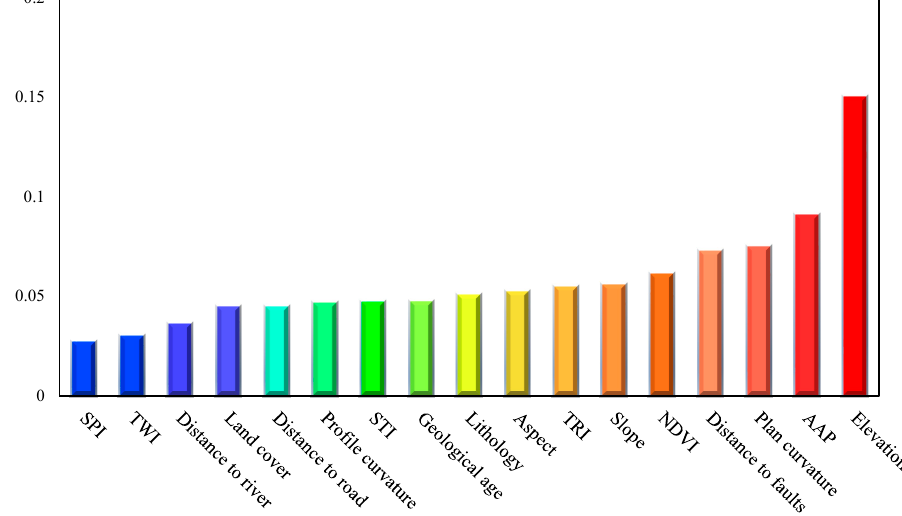
Figure 4. The feature importance calculated by the GBDT_B model.